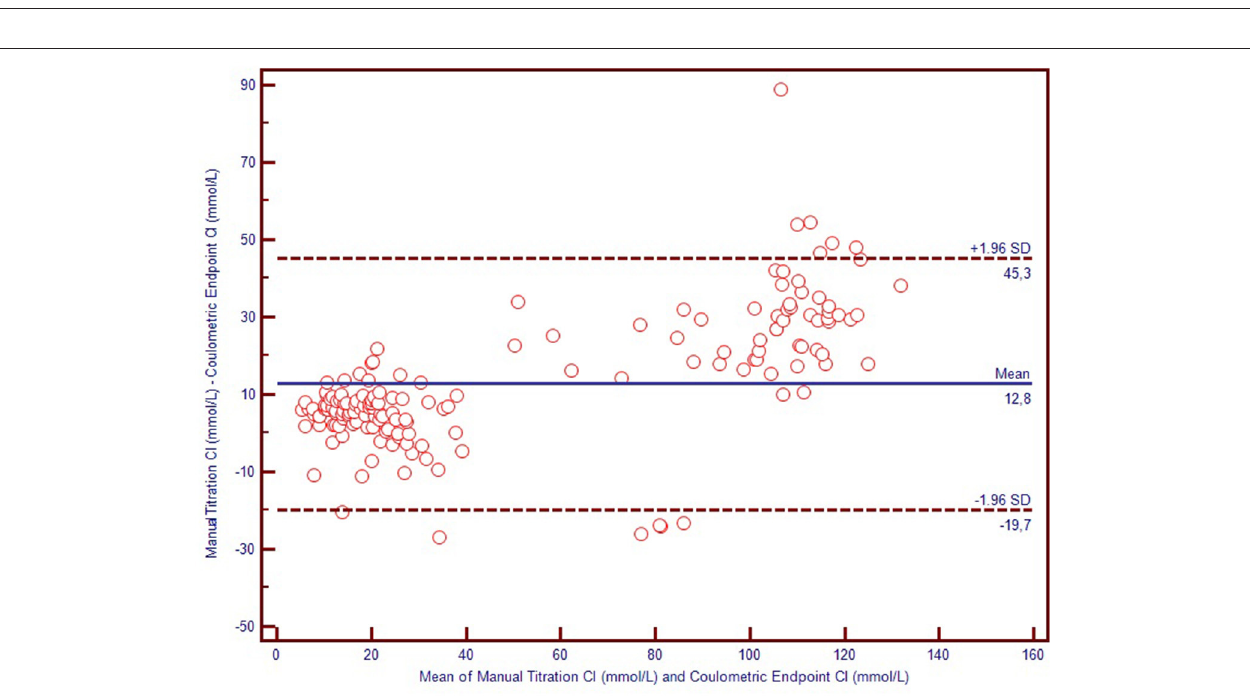
FIGURE 3 | Bland-Altman Plot of manual titration vs. coulometric endpoint method.